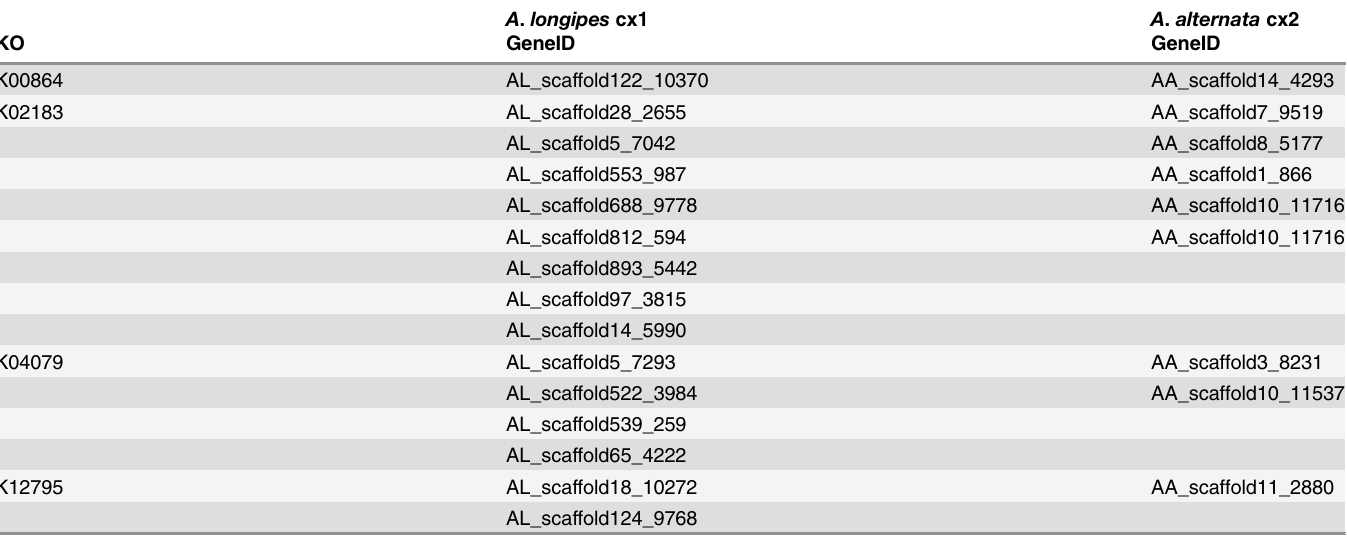
Table 4. Genes related to KEGG plant-pathogen